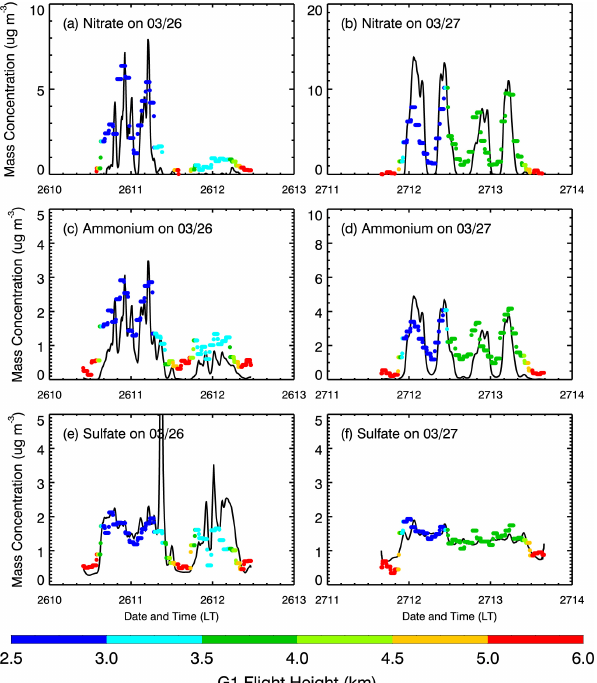
Fig. 4. Comparison of C-130 aircraft measured (dots with different colors) and simulated (black line) BC, nitrate, ammonium, sulfate, and organic aerosols along the flight track on 29 March. See Fig. 2 for the x-axis